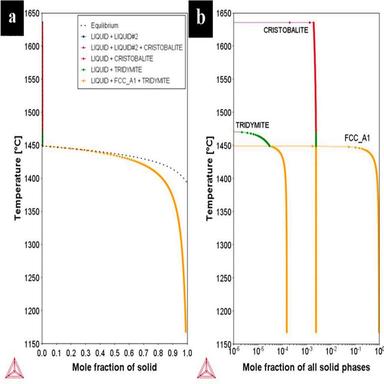
Thermodynamic calculations on solidification process of 15-5PH stainless steel, based on Scheil-Gulliver non-equilibrium solidification: (a) total solid mole fraction, and (b) mole fraction of individual solid phases.